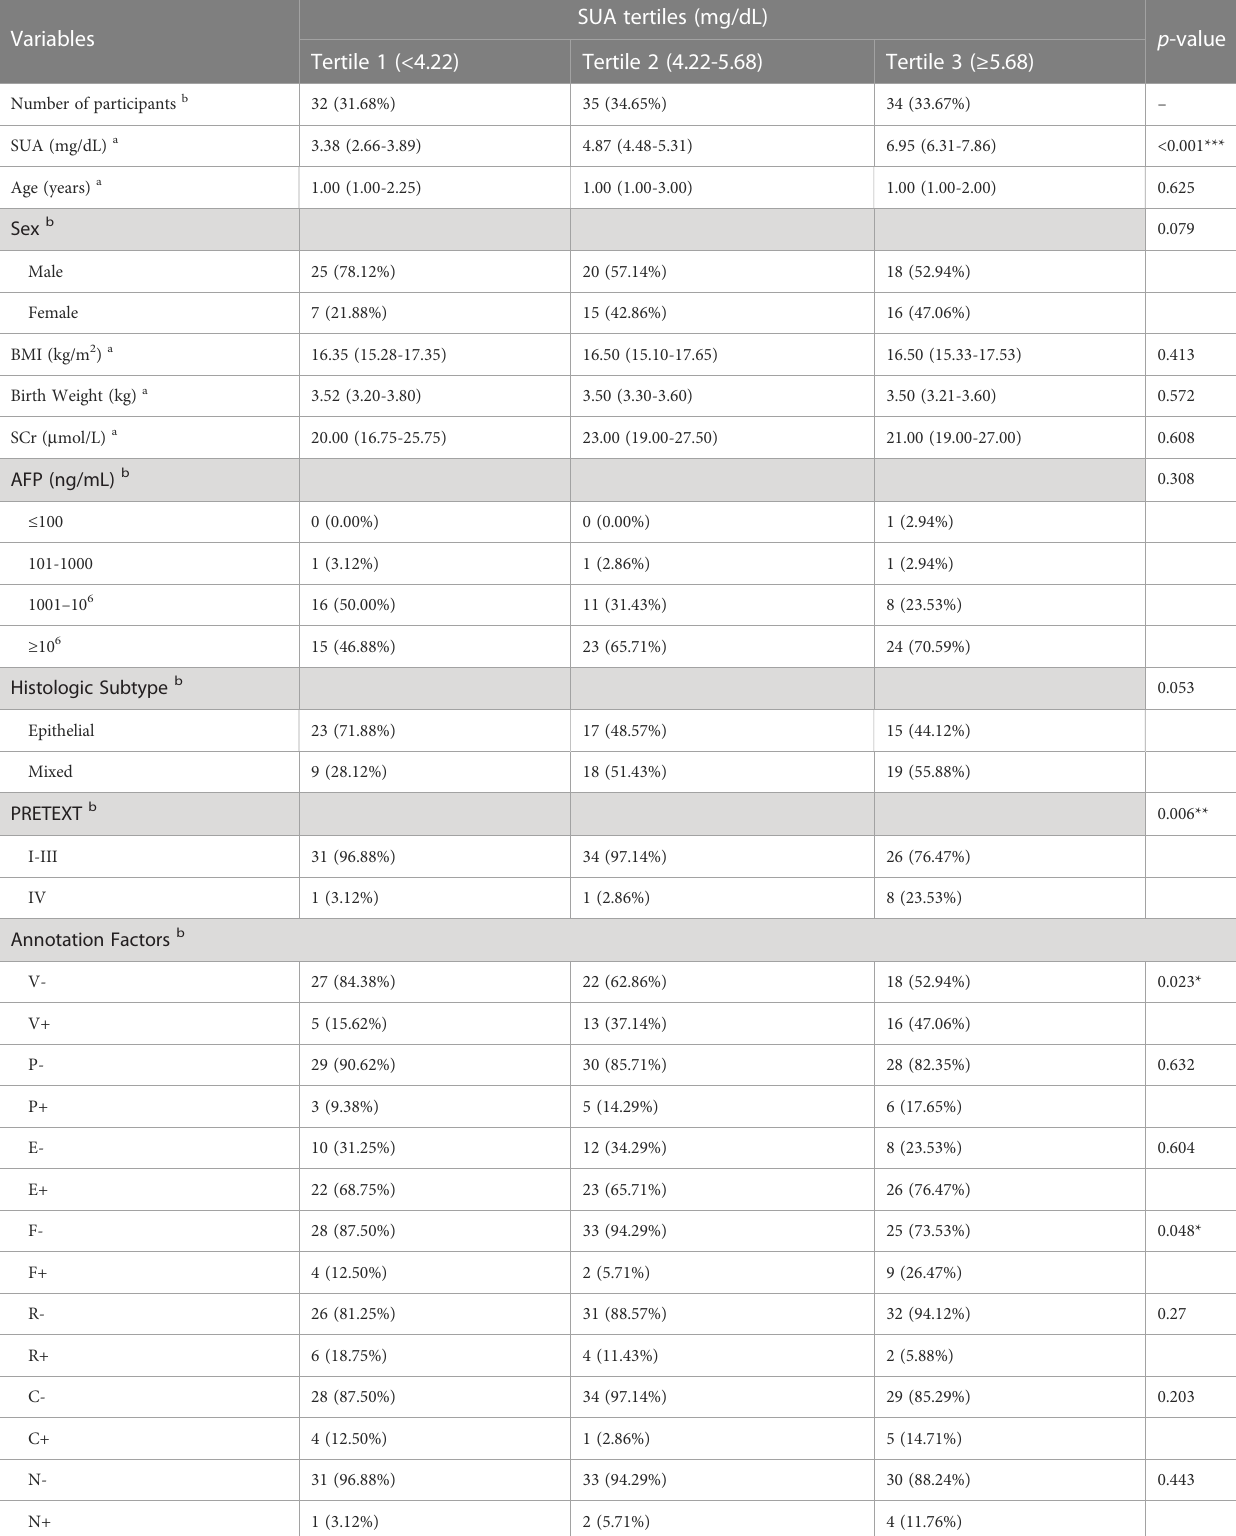
TABLE 1 Patient demographics and clinical characteristics by tertiles of serum uric acid at